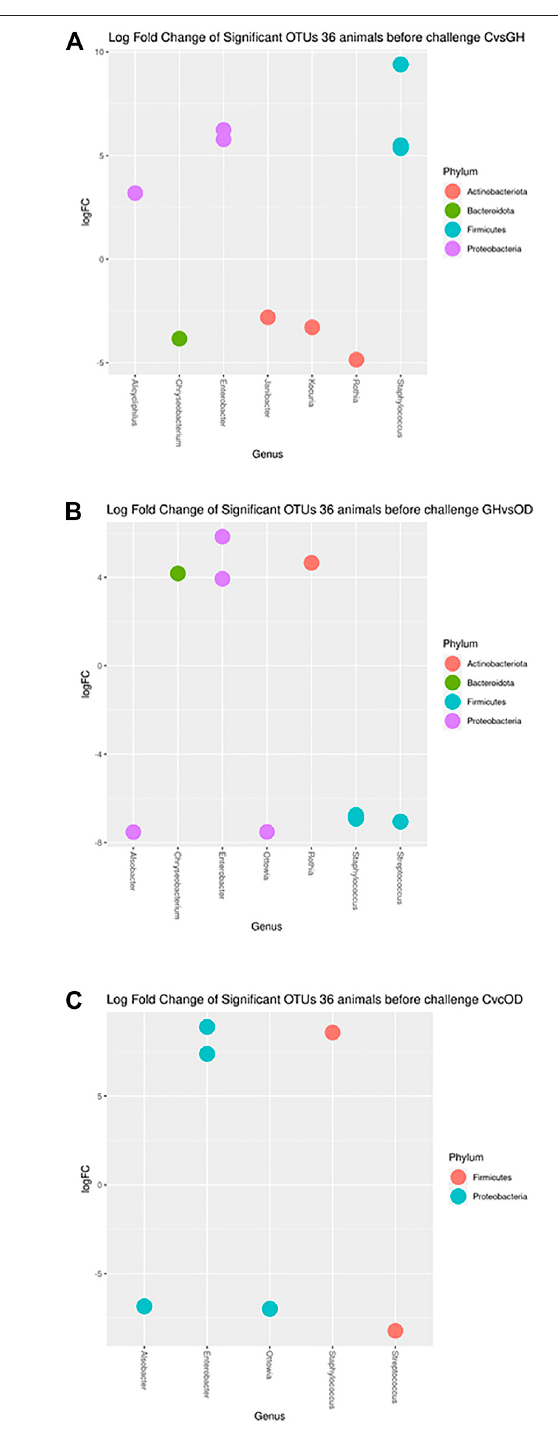
FIGURE 3 | Log fold changes of signi fi cant OTUs before LPS/SAL challenge in the different housing systems: crates (C) – n = 9; indoor group- housing (GH) – n = 14; and outdoor group-housing (OD) – n = 13. (A) Positive values correspond to C animals, and negative values correspond to GH animals. (B) Positive values correspond to GH animals, and negative values correspond to OD animals. (C) Positive values correspond to C animals, and negative values correspond to OD animals.